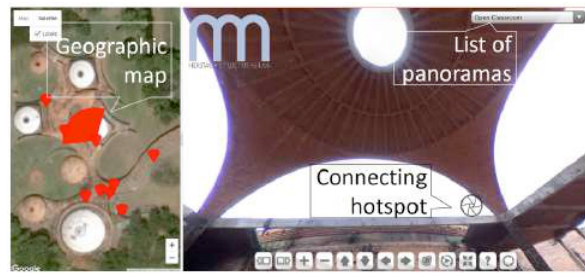
Figure 8. Interface for VT/IM environment (R. Napolitano, I. Douglas, M.E. Garlock, B. Glisic, 2017)